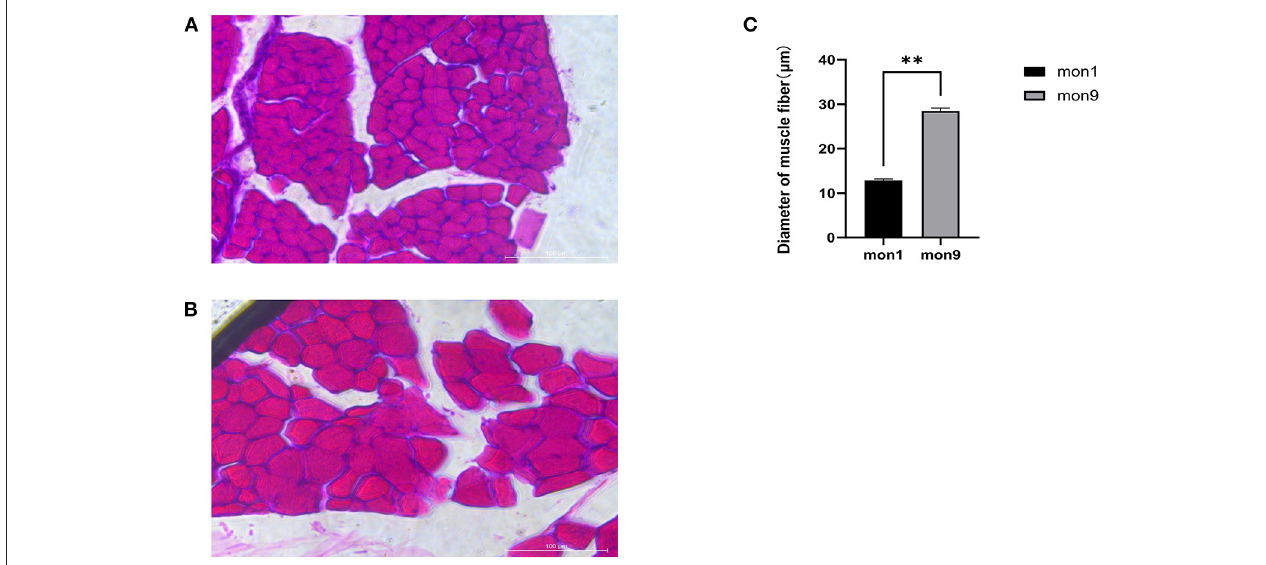
FIGURE 1 | HE staining of muscle tissue frozen sections. (A) muscle fibers of mon1 group. (B) muscle fibers of mon9 group. (C) diameter comparison of muscle fibers.